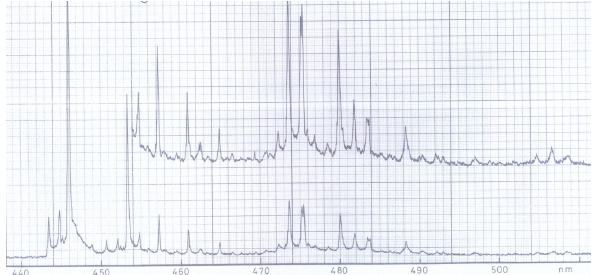
Figure 1. The spectra of quasilinear photoluminescence of perylene in n-hexane (Nakhimovsky et al. 1989).